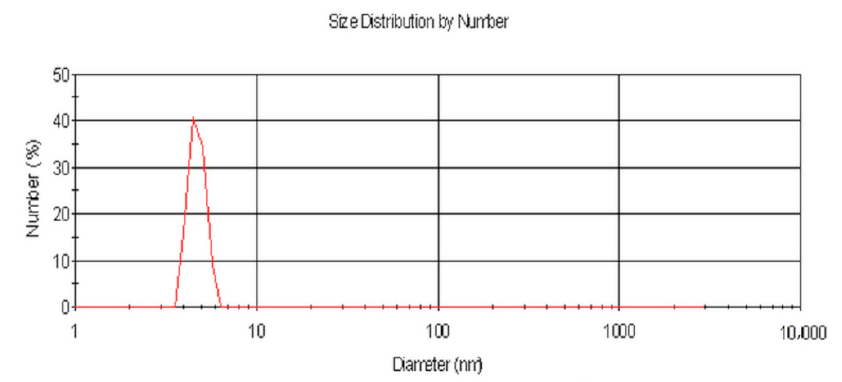
Figure 3. ParticlesizedistributionofZnS:MnnanoparticlesstabilisedbyCYSandDBSAintetrahydrofuran. Figure 3. Particle size distribution of ZnS:Mn nanoparticles stabilised by CYS and DBSA in tetrahydrofuran.